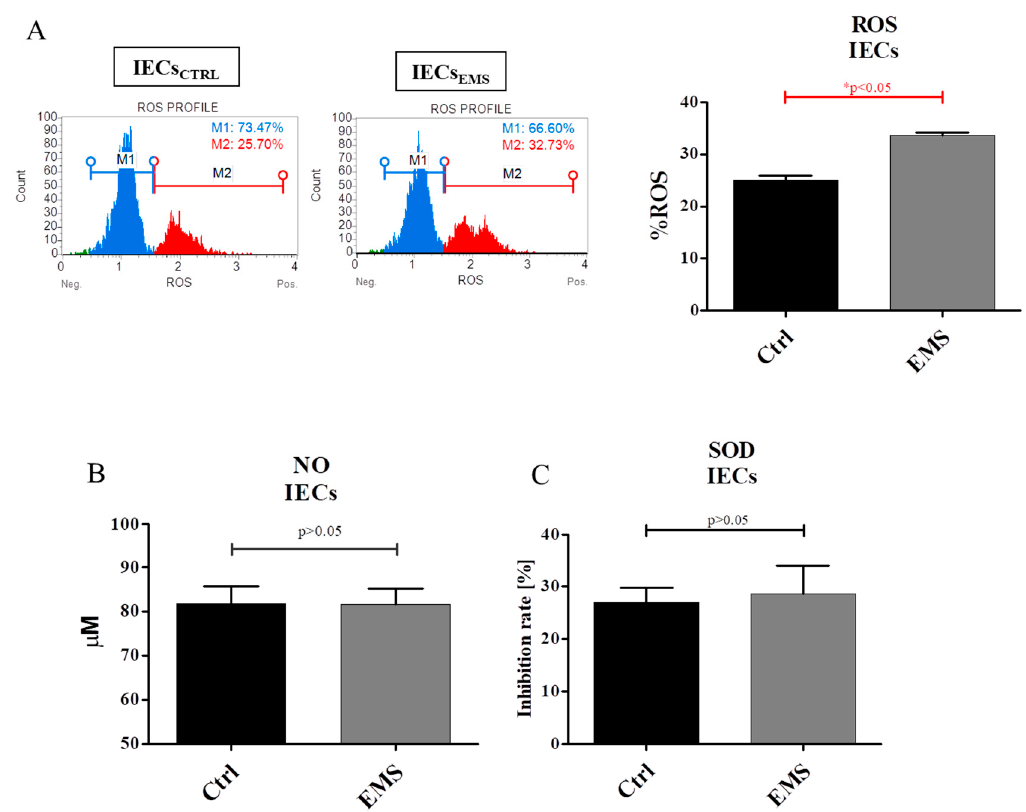
Figure 8. Oxidative stress factors in IECs cultures. The amount of ROS was elevated in IECs EMS in comparison to control group ( A ), whereas NO amount analysis showed no significant differences between groups ( B ). Similarly, the activity of the antioxidative enzyme SOD (C) was comparable in IECs CTRL and IECs EMS . Results expressed as mean ± S.D. * p < 0.05.